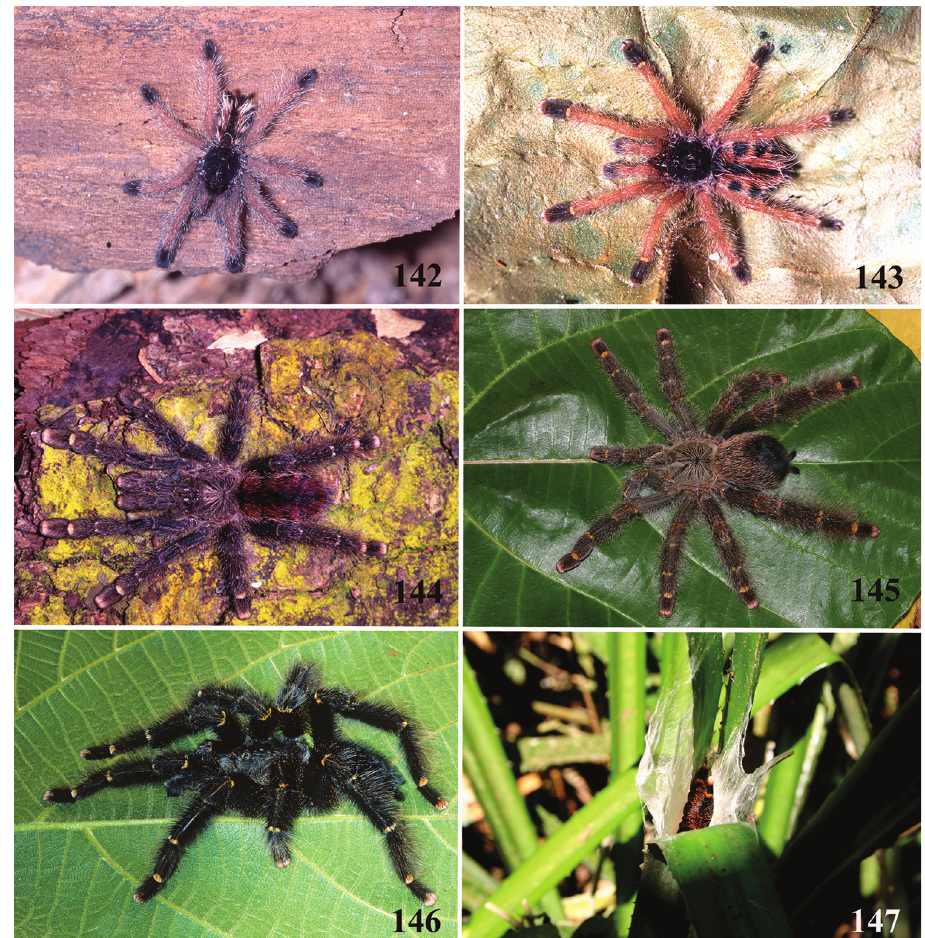
Figures 142–147. Avicularia rufa Schiapelli & Gerschman, 1945, habitus and retreat. 142 immature 143 juvenile 144 old juvenile 145 female 146 male 147 retreat on bromelid. Photos: 142–145, 147 R. Bertani; 146 W.